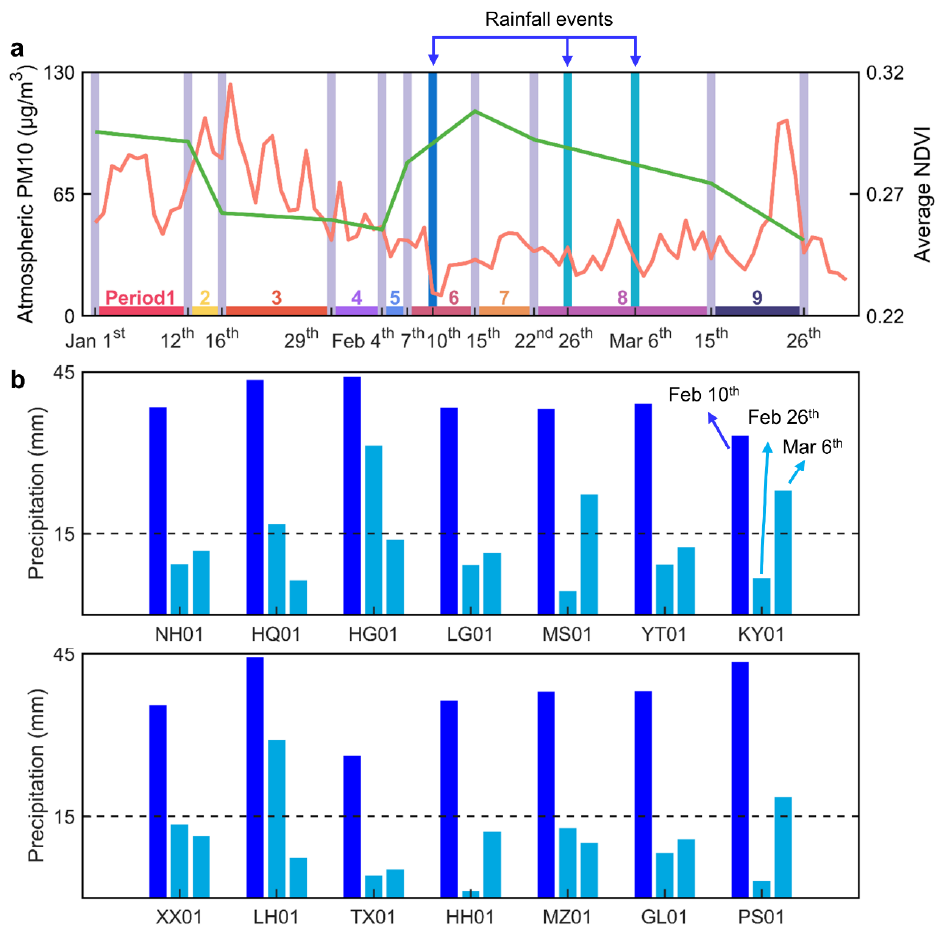
Figure 2. Overview of observational events and rainfall events. ( a ) Orange and green lines show the daily variations in average PM10 concentration and the normalized difference vegetation index (NDVI) of all stations, respectively. Lavender bars = 10 days of remote sensing data collection. Since the availability of remote sensing satellite imagery is limited by cloud cover, all sampling days exhibited clear skies; dark blue bars = rain on 10 February; light blue bars = rains on 26 February and 6 March. The colored bars during the two collection days represent periods 1–9. ( b ) Simulated precipitation (interpolated by Kriging) for the three rainfall events at each station in the study period. Dark blue bars = rain on 10 February; light blue bars = rain events on 26 February and 6 March. A boundary line of 14mm of precipitation is marked (which is considered the lowest limit for complete removal of foliar